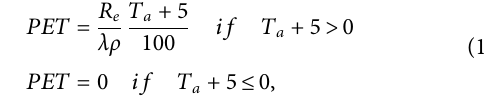
Frontiers in Environmental Science |